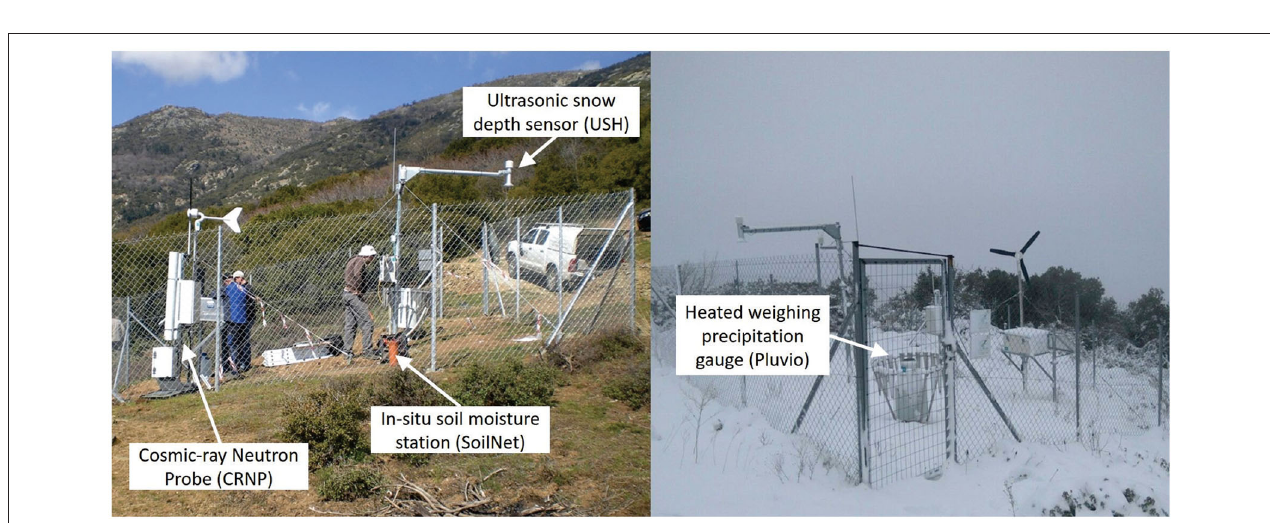
FIGURE 2 | The CS3 test site during installation in spring 2017 (Left) and in the winter period on November 30, 2018 (Right) .